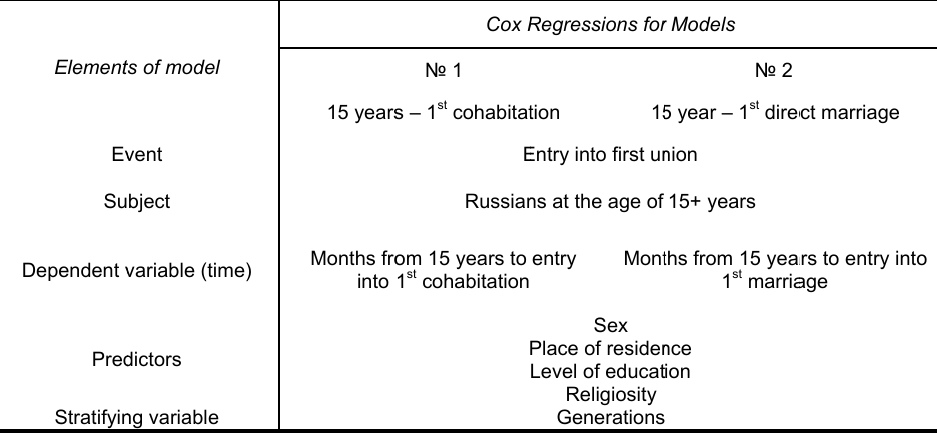
in the anal age